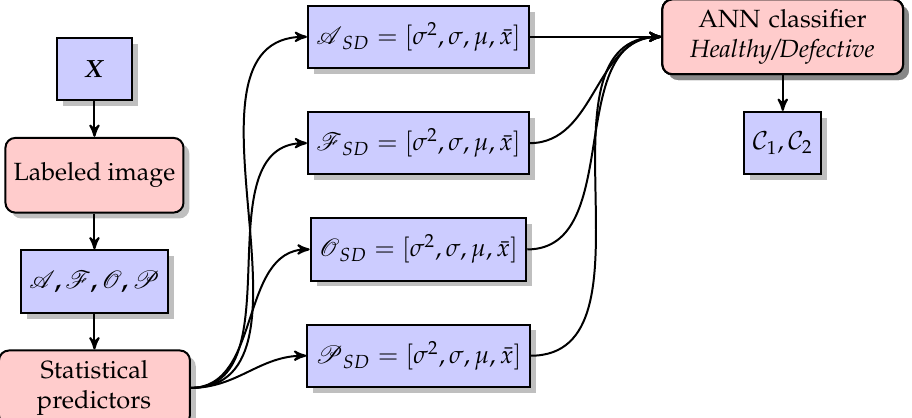
Figure 8. The methodology used in descriptive statistics for each disease and defect. Statistical predictors such as variance ( σ 2 ), standard deviation ( σ ), mean ( µ ), and median ( ˆ x ) are the inputs to be classified using a neural network. The Output is the class raspberry healthy ( C 1 ) or the class raspberry defective ( C 2